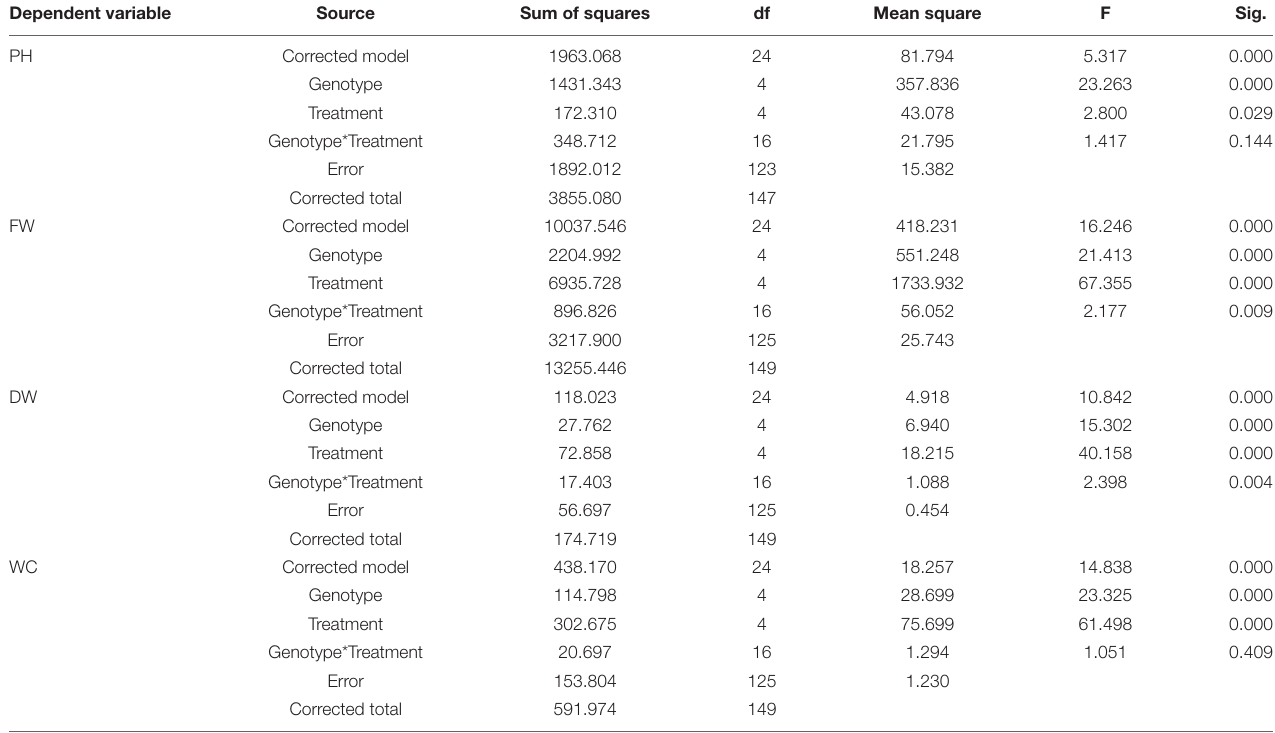
TABLE 6 | Results of the two-way ANOVA (tests of between-subjects effects) on PH, and plant aboveground FW, DW, and WC data at T f , with “genotype” and “treatment” as fixed factors. Dependent variable